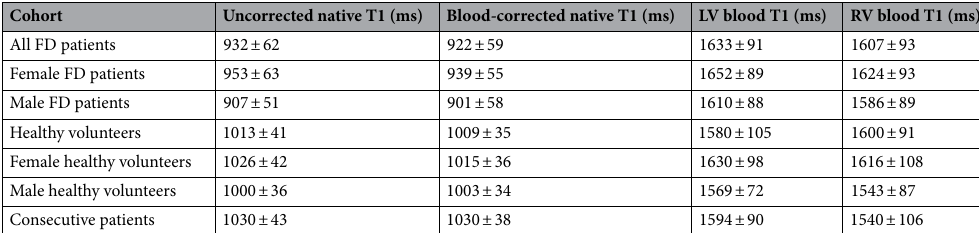
Table 2. Native T1 values in FD patients and healthy volunteers. Data presented as mean ± SD. FD Fabry disease, LV left ventricle, RV right ventricle.